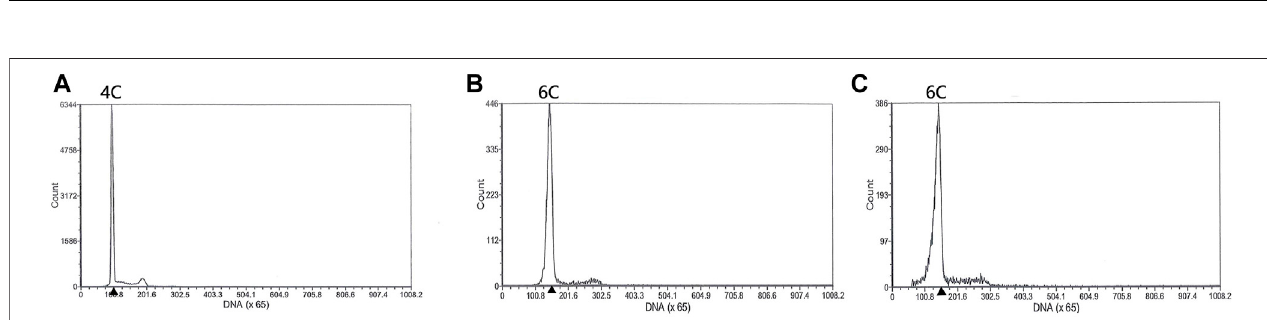
FIGURE5| Flowcytometryhistogramsofbloodcellsobtainedfromprogenyofdifferentcrossingprogeny.ThebloodcellsofRCCweredetectedasthecontrol. (A) Blood cells of RCC (DNA content, 4C). (B) Blood cells of the progeny in 3nDTCC( \ ) × 2nDTCC( _ ) (DNA content, 6C). (C) Blood cells of the progeny in 3nDTCC( \ ) × 3nDTCC( _ ) (DNA content, 6C).